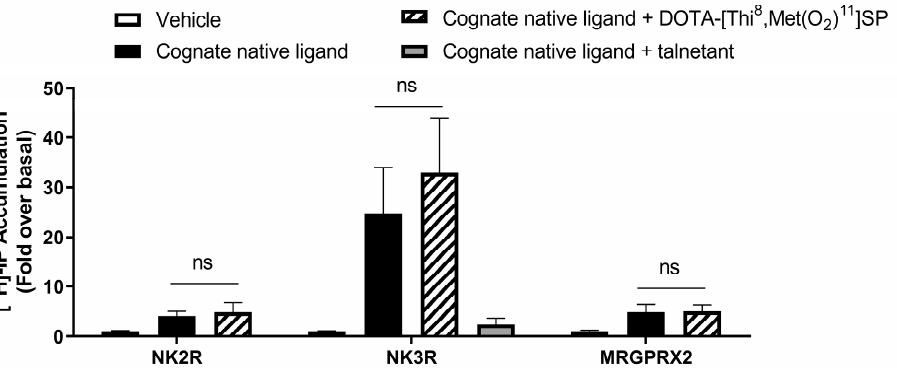
Figure 4. The effect of DOTA-[Thi 8 ,Met(O 2 ) 11 ]SP on activation of NK2R, NK3R and MRGPRX2